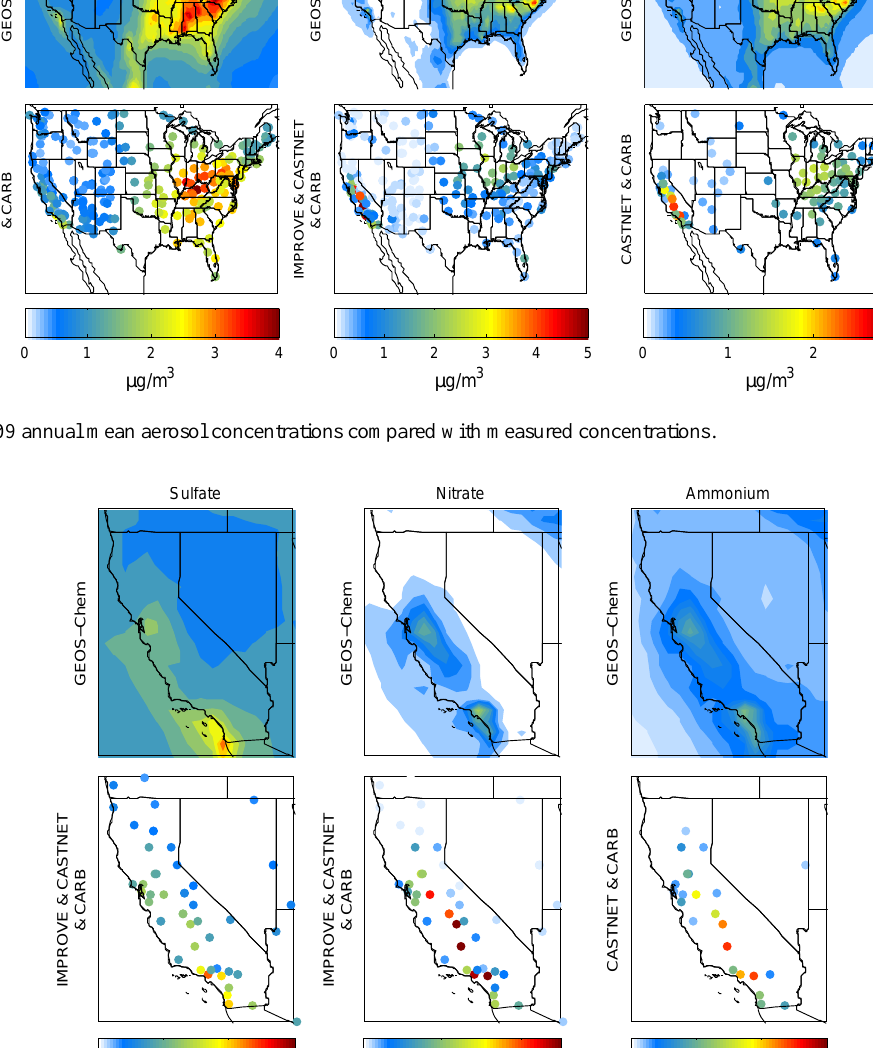
Fig. 5. Scatter plots of predicted versus measured annual